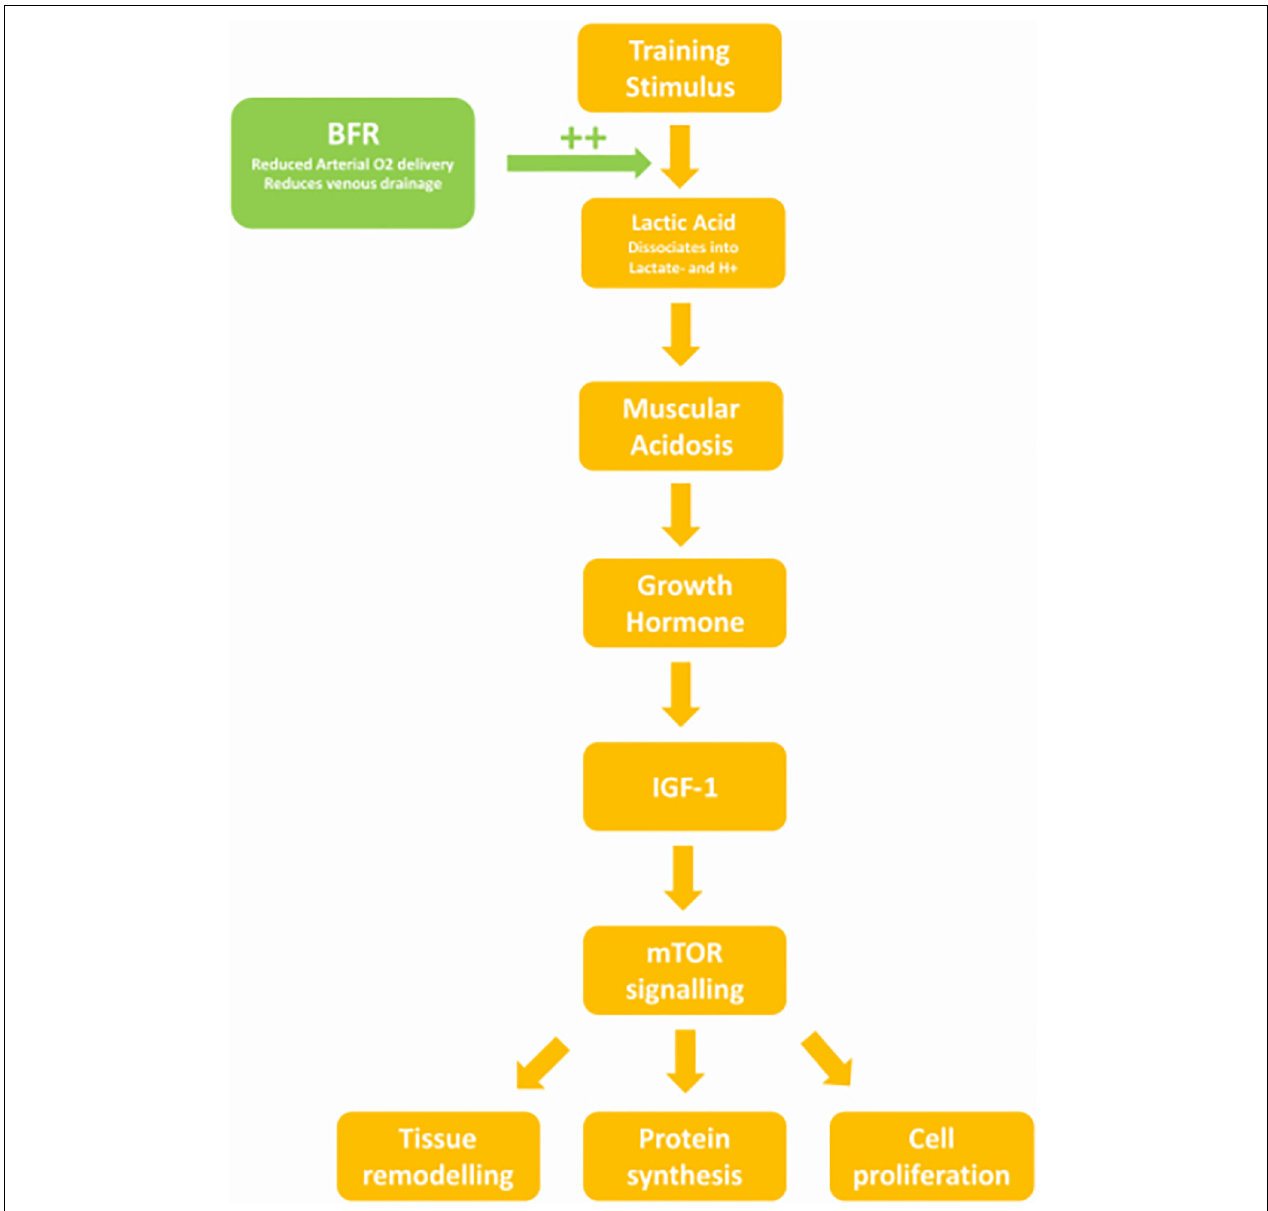
FIGURE 6 | Flowchart demonstrating the physiological effect of